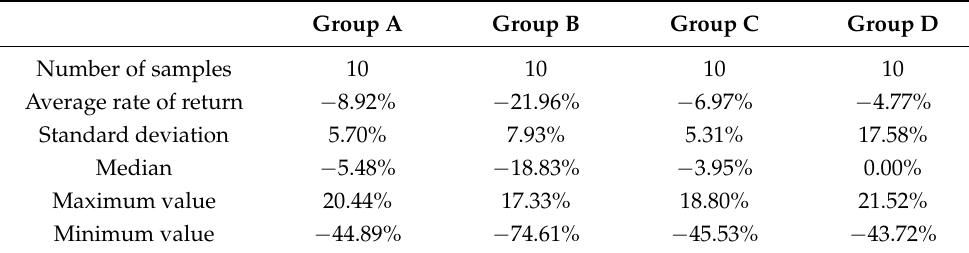
Table 7. Empirical results of groups A–D’s investment strategies.